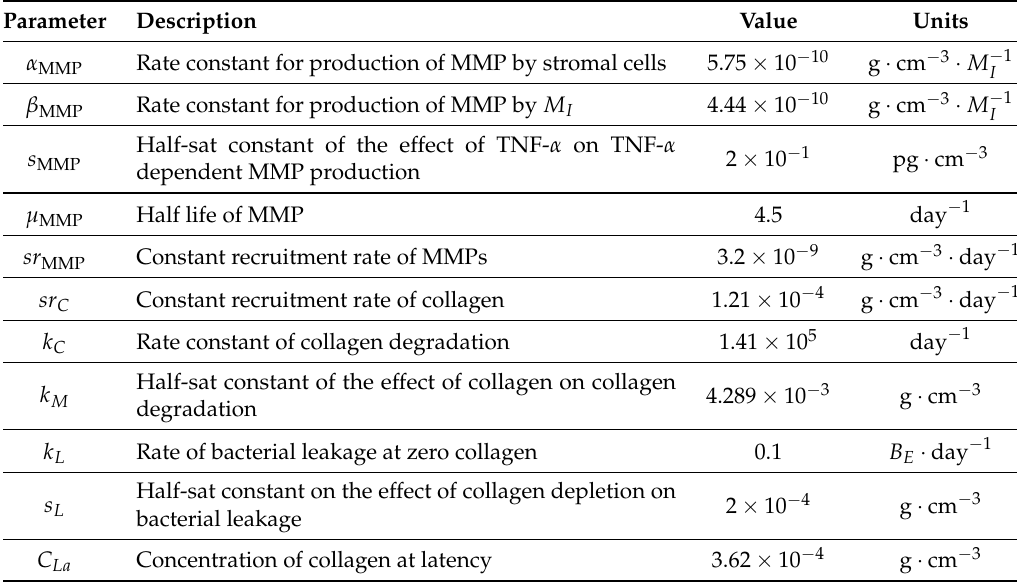
Table 1. Parameters in the tuberculosis (TB) granuloma activation model (MMP: matrix metalloproteinase; M I : infected macrophages; TNF: tumor necrosis